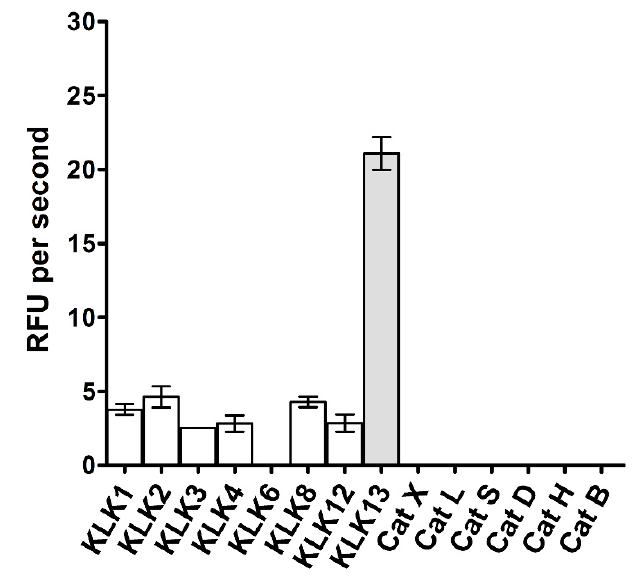
Figure 2. Selectivity of the optimized substrate 2 (ABZ-Val-Arg-Phe-Arg-Ser-Thr-Gln-Tyr(3-NO 2 )-NH 2 ). Activity of selected kallikrein family proteases (KLK1, KLK2, KLK3, KLK4, KLK6, KLK8, KLK12, KLK13) and cathepsins (CatX, CatL, CatS, CatD, CatH, CatB) against the tested substrate was monitored at equal enzyme concentrations in the KLK13-optimized buffer. The fluorescence of the released ABZ-Val-Arg-Phe-Arg fragment was monitored at excitation and emission wavelengths 320 and 450 nm, respectively.